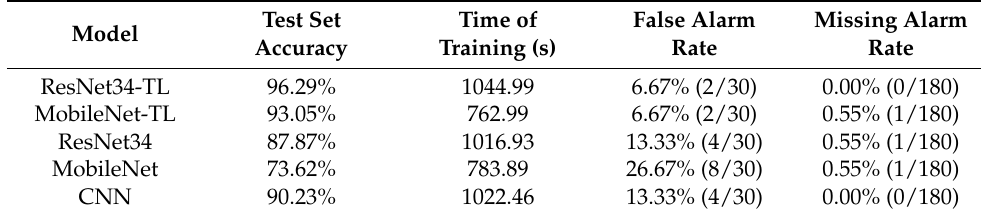
Table 5. Average results for each model.